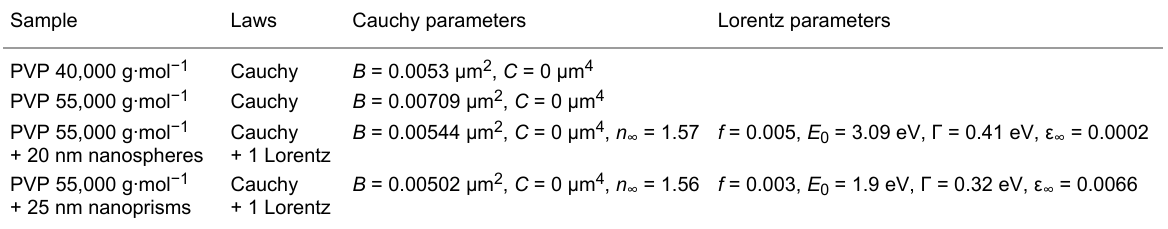
Table 1: Fitting parameters of spectroscopic ellipsometry measurements for different structures.